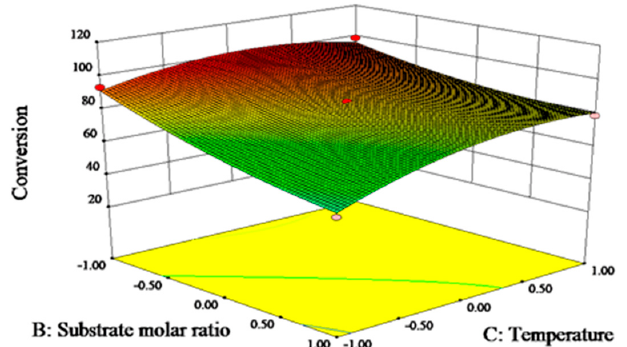
Figure 13. Temperature and the substrate molar ratio affect the conversion efficiency of the enzyme catalytic reaction. For the temperature axis, “ − 1–1” represents temperatures from 15 ◦ C to 45 ◦ C. For the substrate molar ratio axis, “ − 1–1” represents the content of sodium hexametaphosphate from 20 g/L to 100 g/L.